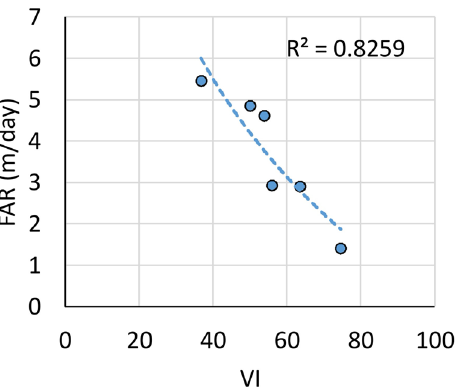
Fig. 17 Determination of operation efficiency in considered panels